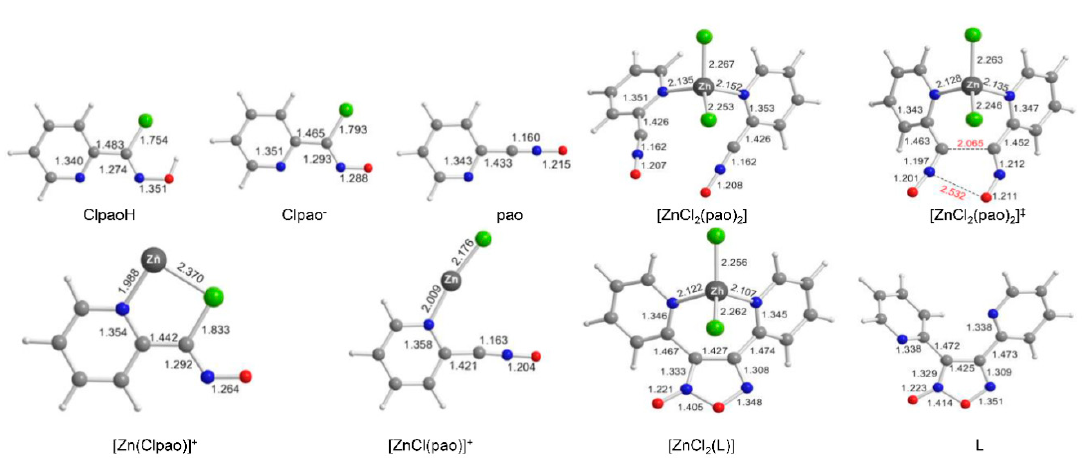
Figure 9. Equilibrium geometries of the ligands, intermediates, transition state (TS) and product in MeOH solution optimized at the PBE0/Def2-TZVP(Cr) ∪ 6-31G(d,p)(E)/PCM level of